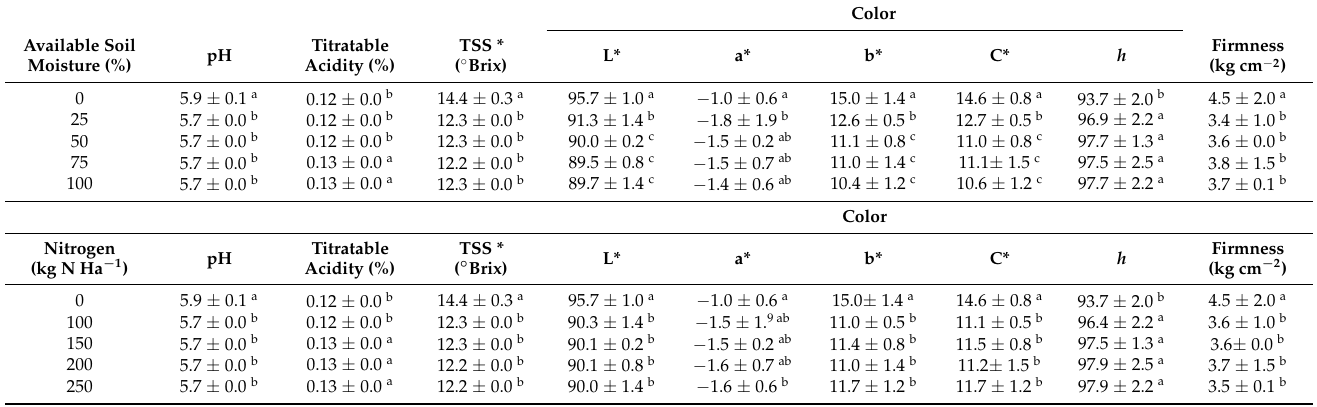
Table 3. Physicochemical parameters of onion bulbs ( Allium cepa L.) in response to available soil moisture and nitrogen